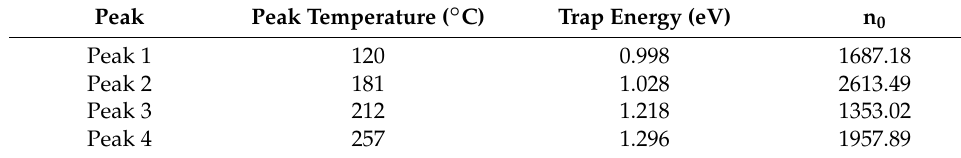
Figure 5. Thermal luminescence glow curves of Yb:LuYAG single crystal. Table 1. Thermally stimulated luminescence (TSL) parameters from the curve fitting.